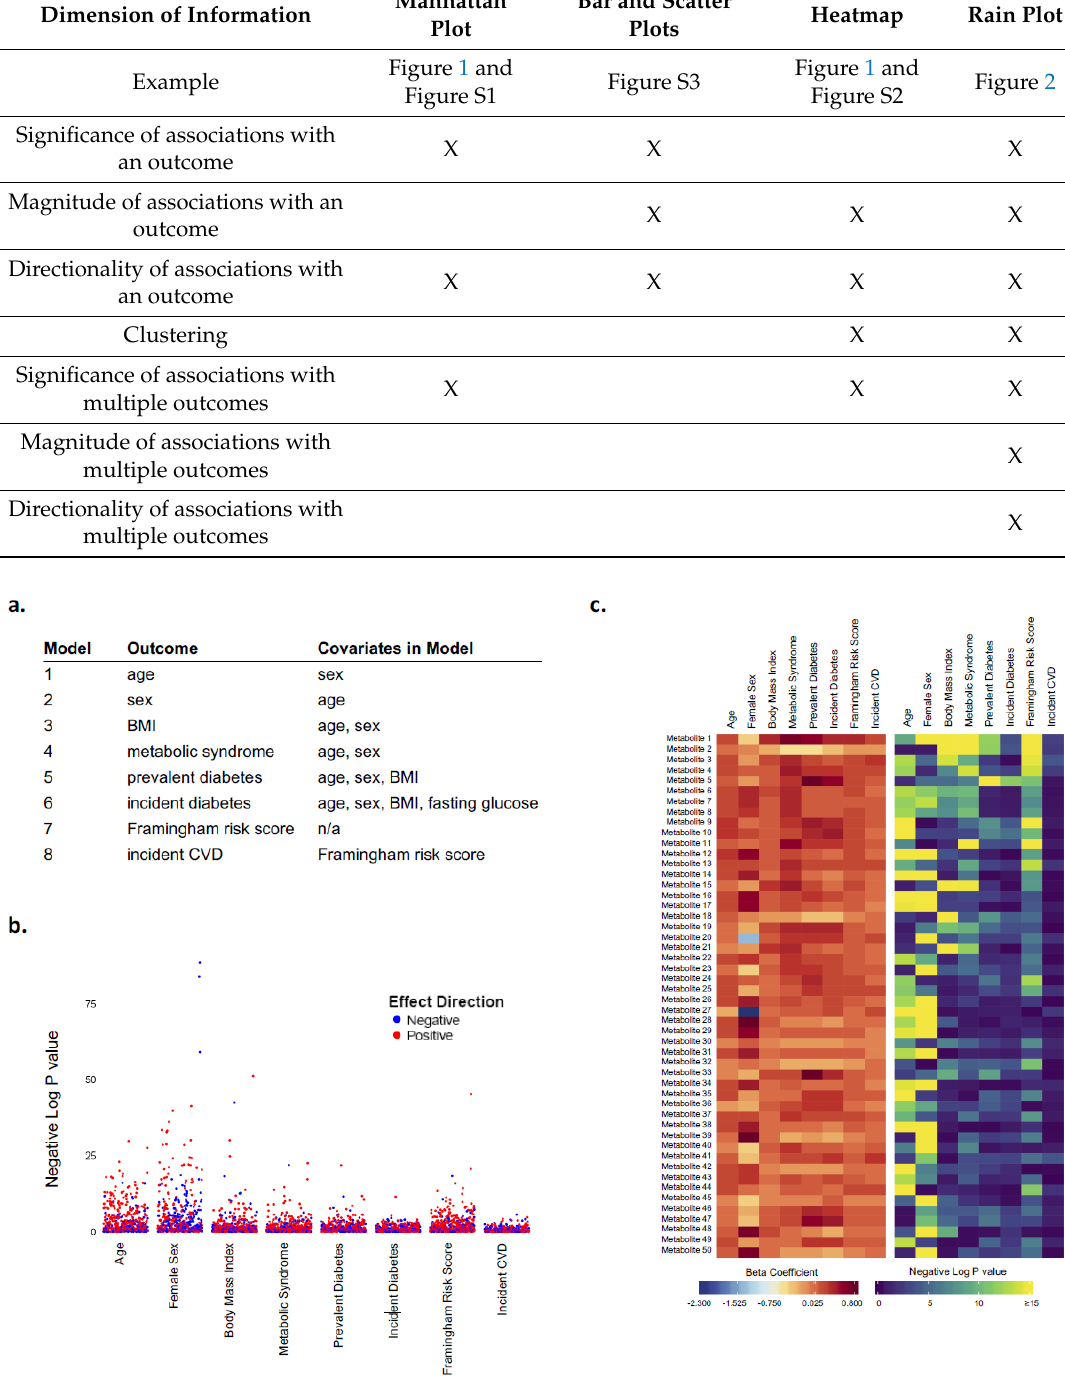
Figure 1. Visualization of complex metabolomics data. For a set of statistical models ( a ) performed in a large human study, for example, a Manhattan plot ( b ) can display the degree to which a wide panel of metabolites is associated with different outcomes although the magnitude of these associations is not conveyed. Pairing of heatmaps can display magnitude as well as directionality and significance for each metabolite association ( c ), although between-metabolite comparisons of associations across all outcomes is not easily discernible .